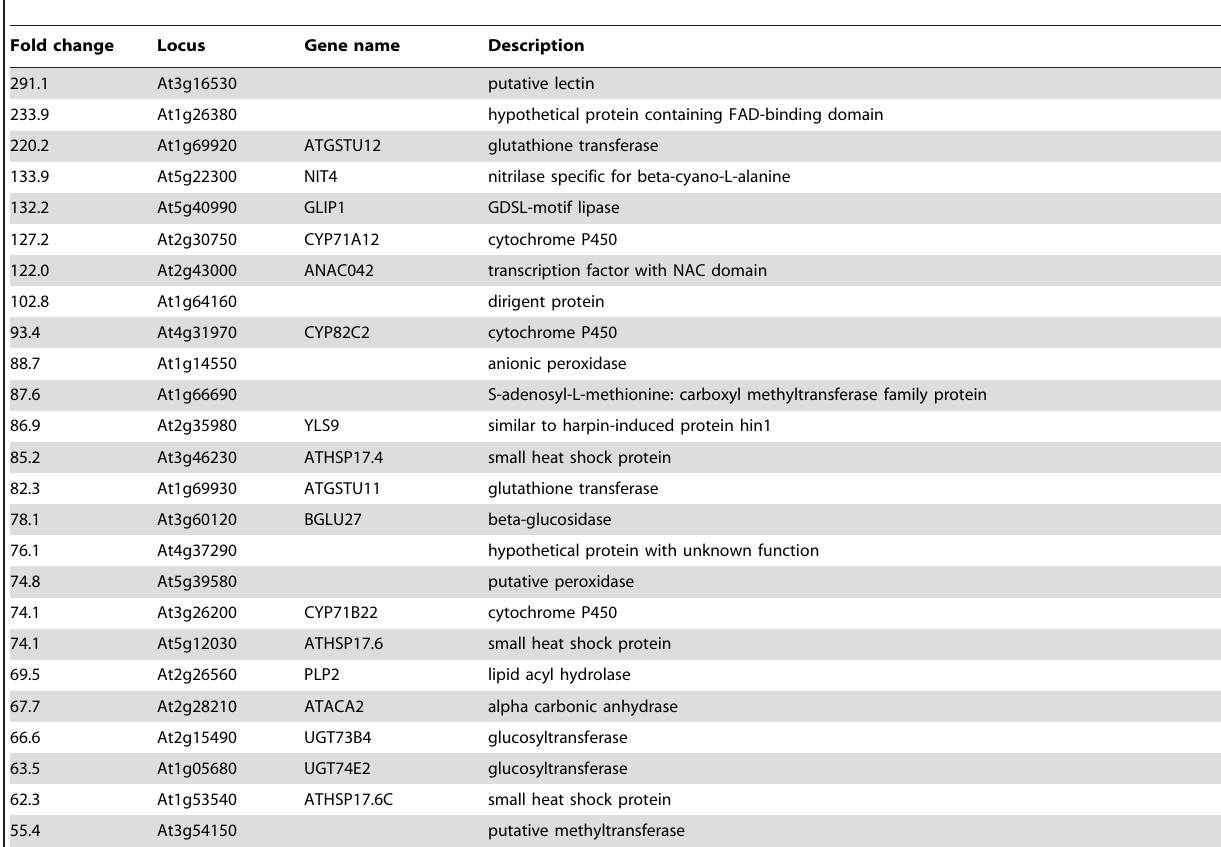
Table 4. Twenty-five genes most up-regulated in response to gold treatment.